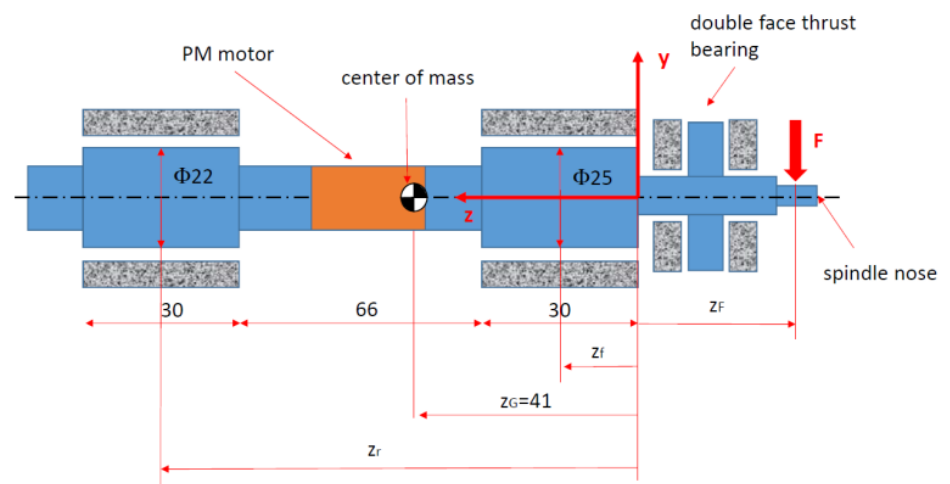
Figure 2. Sketch of the rotor-bearings system. Table 1. Mass properties of rotor.